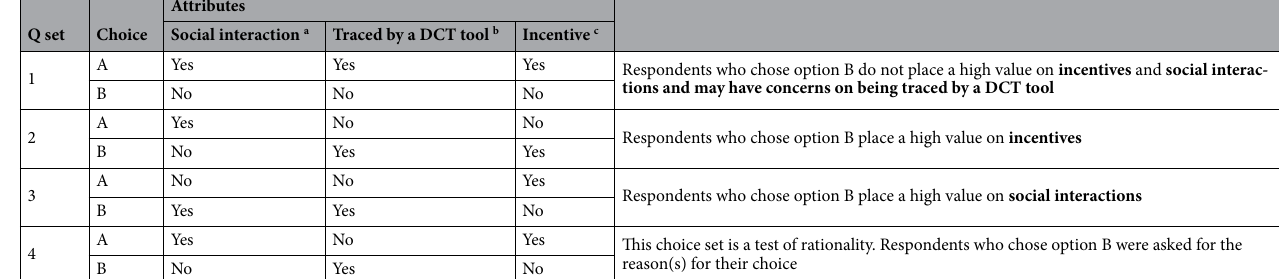
(app or token) within 2 m of each other due to the respondent’s carrying of a DCT tool; and “Incentives” refers to any incentive (e.g., monetary, virtual rewards, lucky draw) which the respondent thought was reasonable to spur him/her to carry a DCT tool and/or to reduce his/her social activities. The questionnaire was piloted over two weeks with 154 respondents to refine the expression based on feedback from respondents. The questionnaire was also translated into Mandarin Chinese to cater to respondents who could not comprehend the English language.